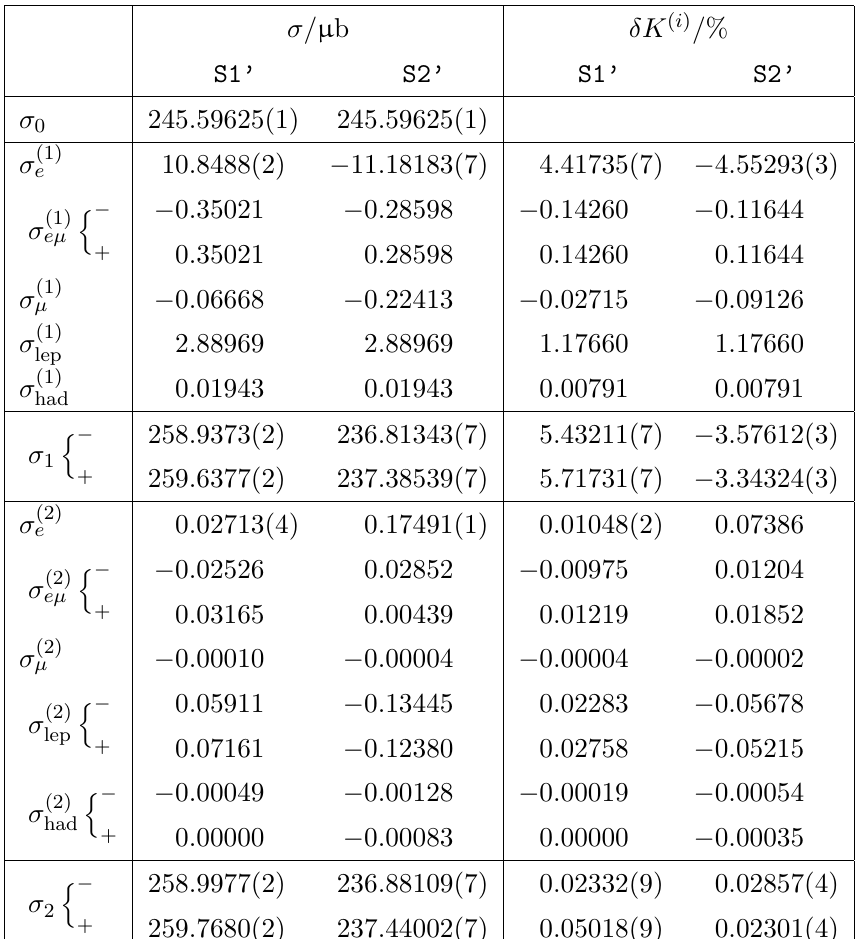
Table 3 . Integrated cross sections for S1 ’ and S2 ’ at LO, NLO, and NNLO. The results are split into photonic, i.e. electronic, mixed and muonic, and fermionic, i.e. leptonic and hadronic, corrections. All three leptons are included in the leptonic contributions. When applicable, the different contributions with negative and positive muons are shown. Where no error is given, all digits are significant compared to the precision of the numerical